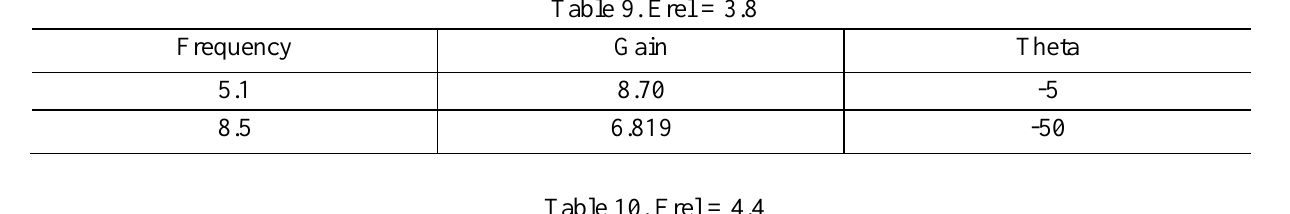
Table 9. Erel = 3.8